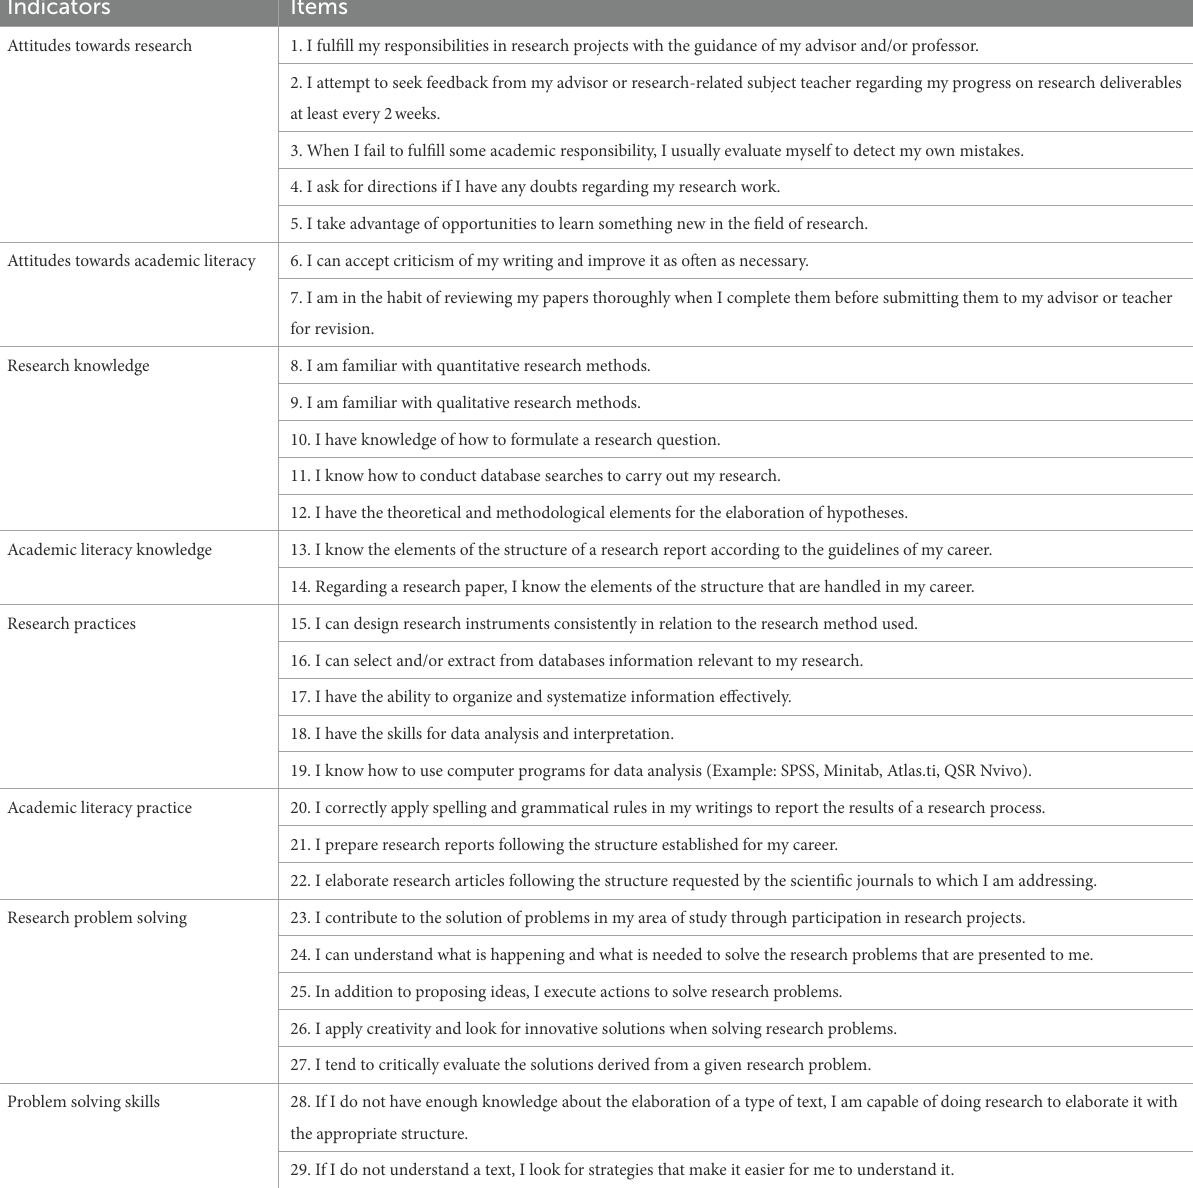
TABLE 1 eResearch&Literacy